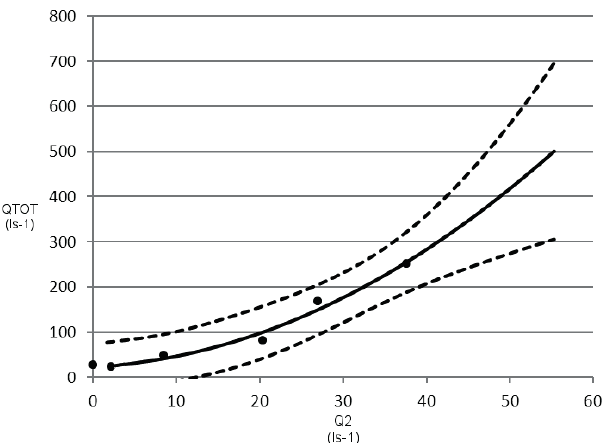
Fig. 2 Curvilinear regression curve (continuous line) obtained from the observed values of QTOT and Q 2 (filled dots). Error bounds (dashed lines) correspond to the 95% confidence intervals.